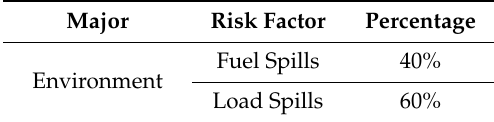
Table 11. Common causes of environmental pollution.